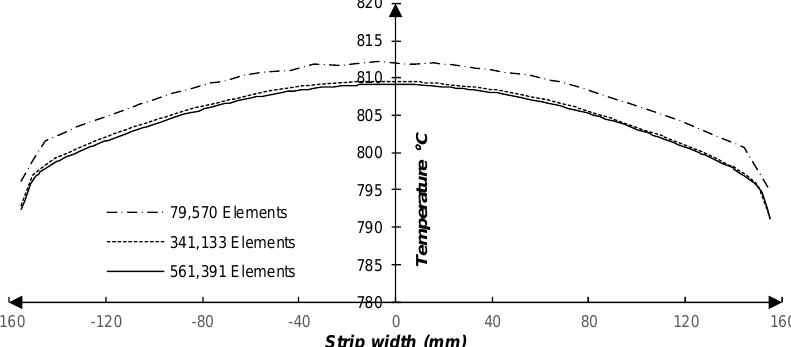
Figure 3. Mesh analysis of the numerical model based on a comparison of the strip temperatures along a line through the y -direction (strip width) located 70 mm before the entrance to the LBE bath.